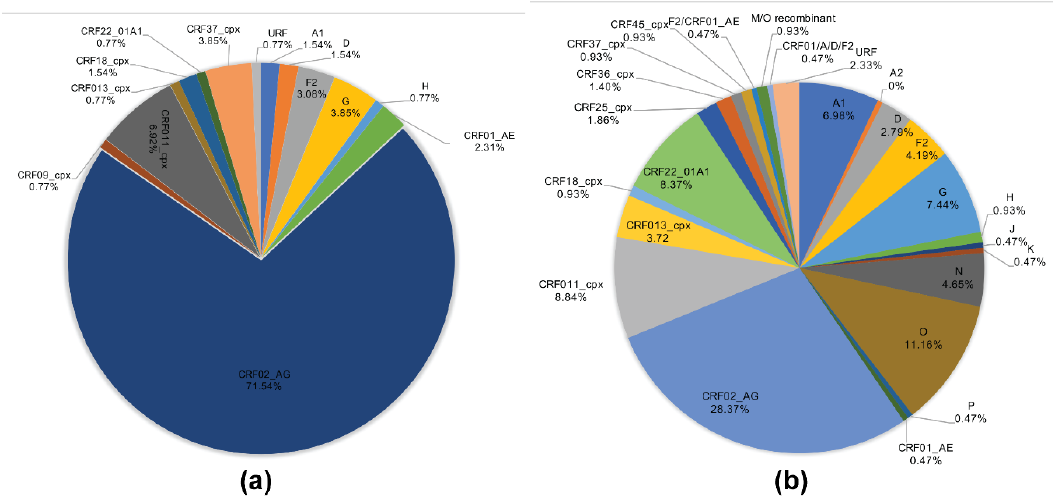
Figure 3. HIV-1 genetic diversity in cohort and database samples. ( a ) Proportions of each HIV-1 subtype and CRFs identified in cohort samples based on NCBI viral genotyping tool (combined analysis of integrase and nef gene sequences). ( b ) Proportions of each HIV-1 subtype and CRFs identified using full-length sequence of database samples, based on NCBI viral genotyping tool. CRF: circulating recombinant form; URF: unique recombinant form.